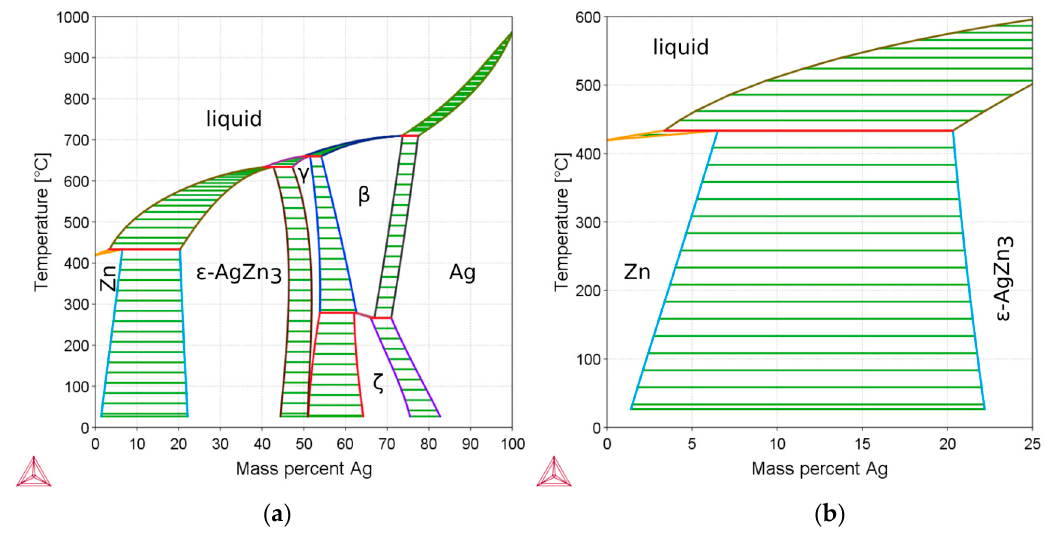
Figure 1. ( a ) Calculated Zn-Ag phase diagram using the Themo-Calc 2017a software (Thermo-Calc Software AB, Solna, Sweden) and the SNOB-3 database. ( b ) Detail of the phase diagram in ( a ) manifesting that up to 6 wt % Ag can be solved in Zn. Upon cooling, the composition enters the two-phase area, i.e., precipitations of ε -AgZn 3 in the Zn matrix occur. As this effect is generally accompanied by an increase in strength, it is referred to as precipitation hardening.